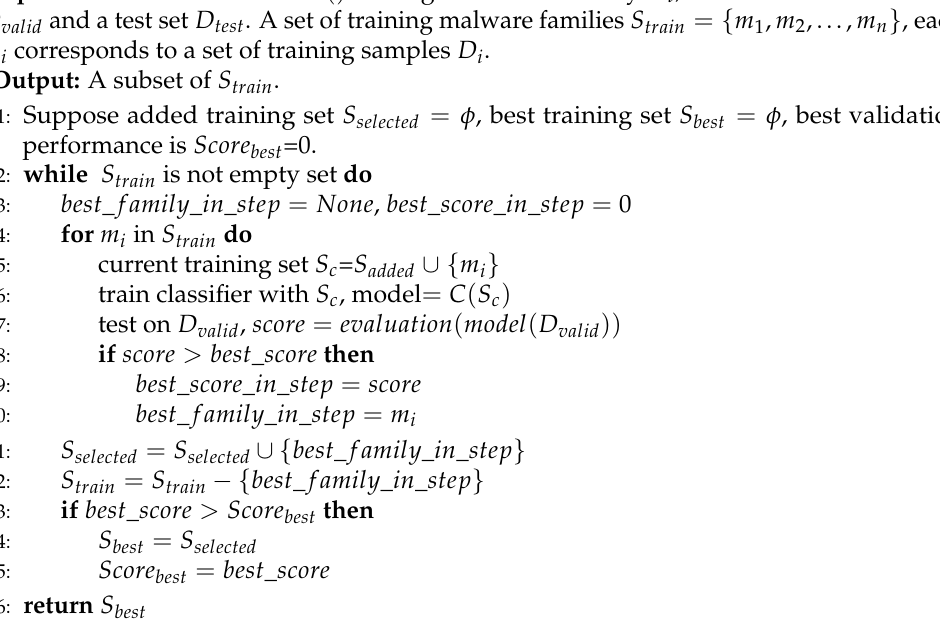
Algorithm 1 Sequential Family Selection algorithm